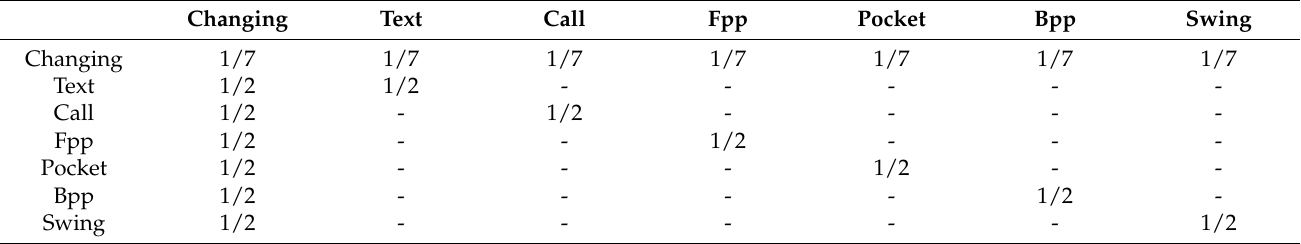
Table 3. Smartphone mode transition probability allocation.